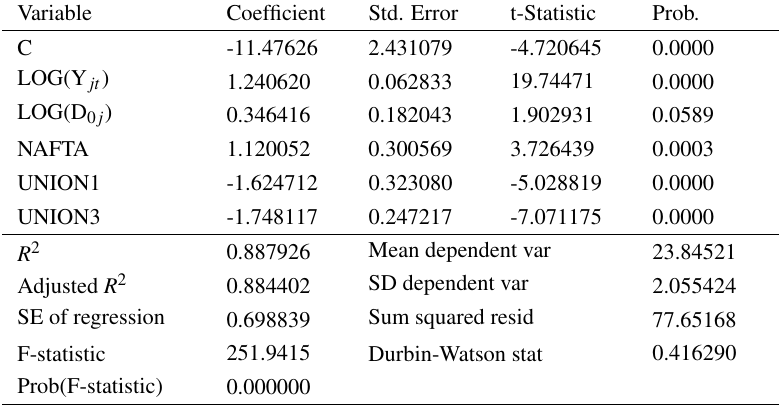
Table 2 Regression analysis of political